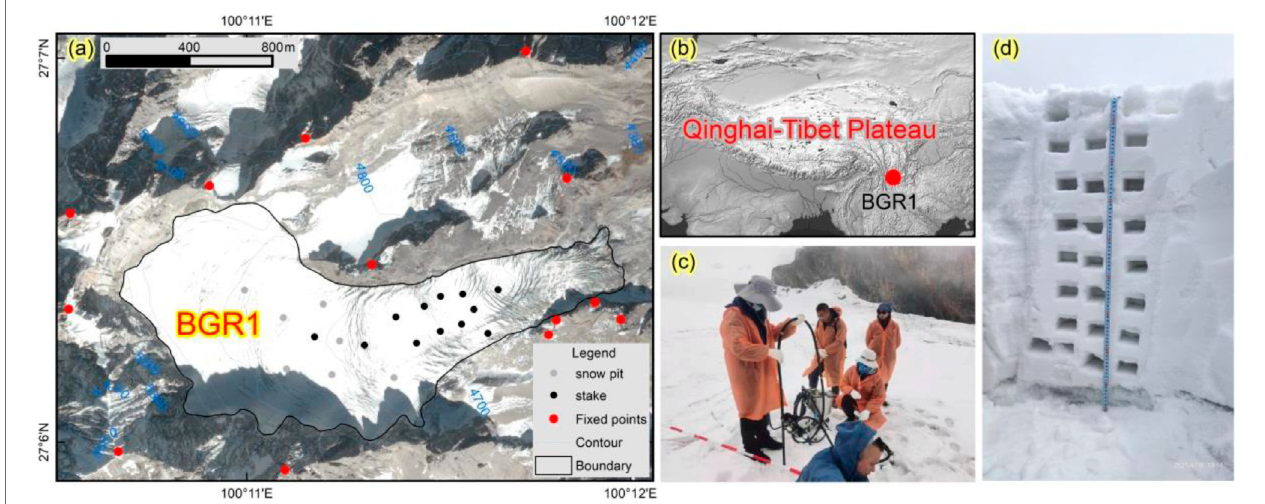
FIGURE1| LocationofthestudyareaandthedistributionofthestakesandsnowpitsontheBaishuiRiverGlacierNo.1(BRG1). (A) Aerialphotooftheobservation network on the Baishui River Glacier No. 1; (B) map showing the location of the study area on the Qinghai – Tibet Plateau; (C) observers inserting a mass – balance stake into the glacier surface; and (D) photo of a snow pit on the glacier surface.